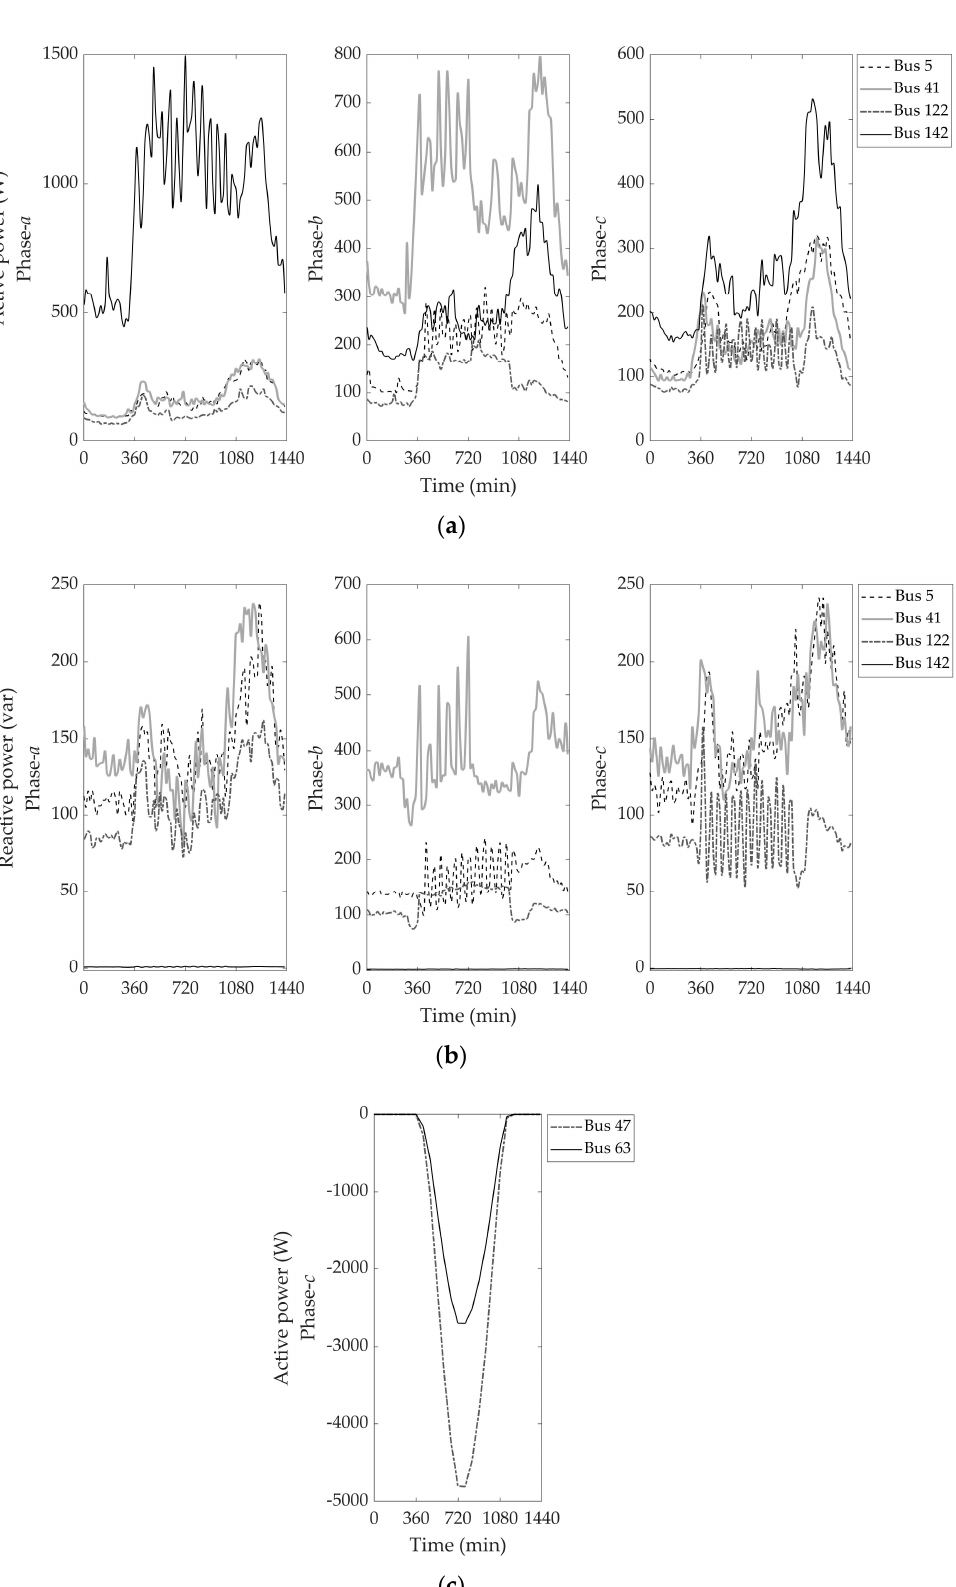
Figure 3. Power profiles of ( a ) active and ( b ) reactive consumption, and ( c ) PV production.